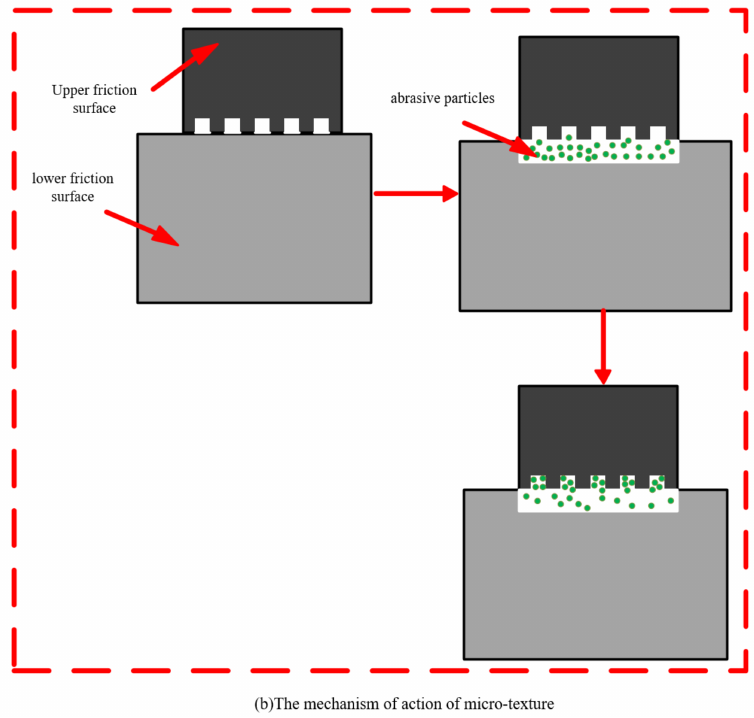
Figure 13. Test process and micro-texture